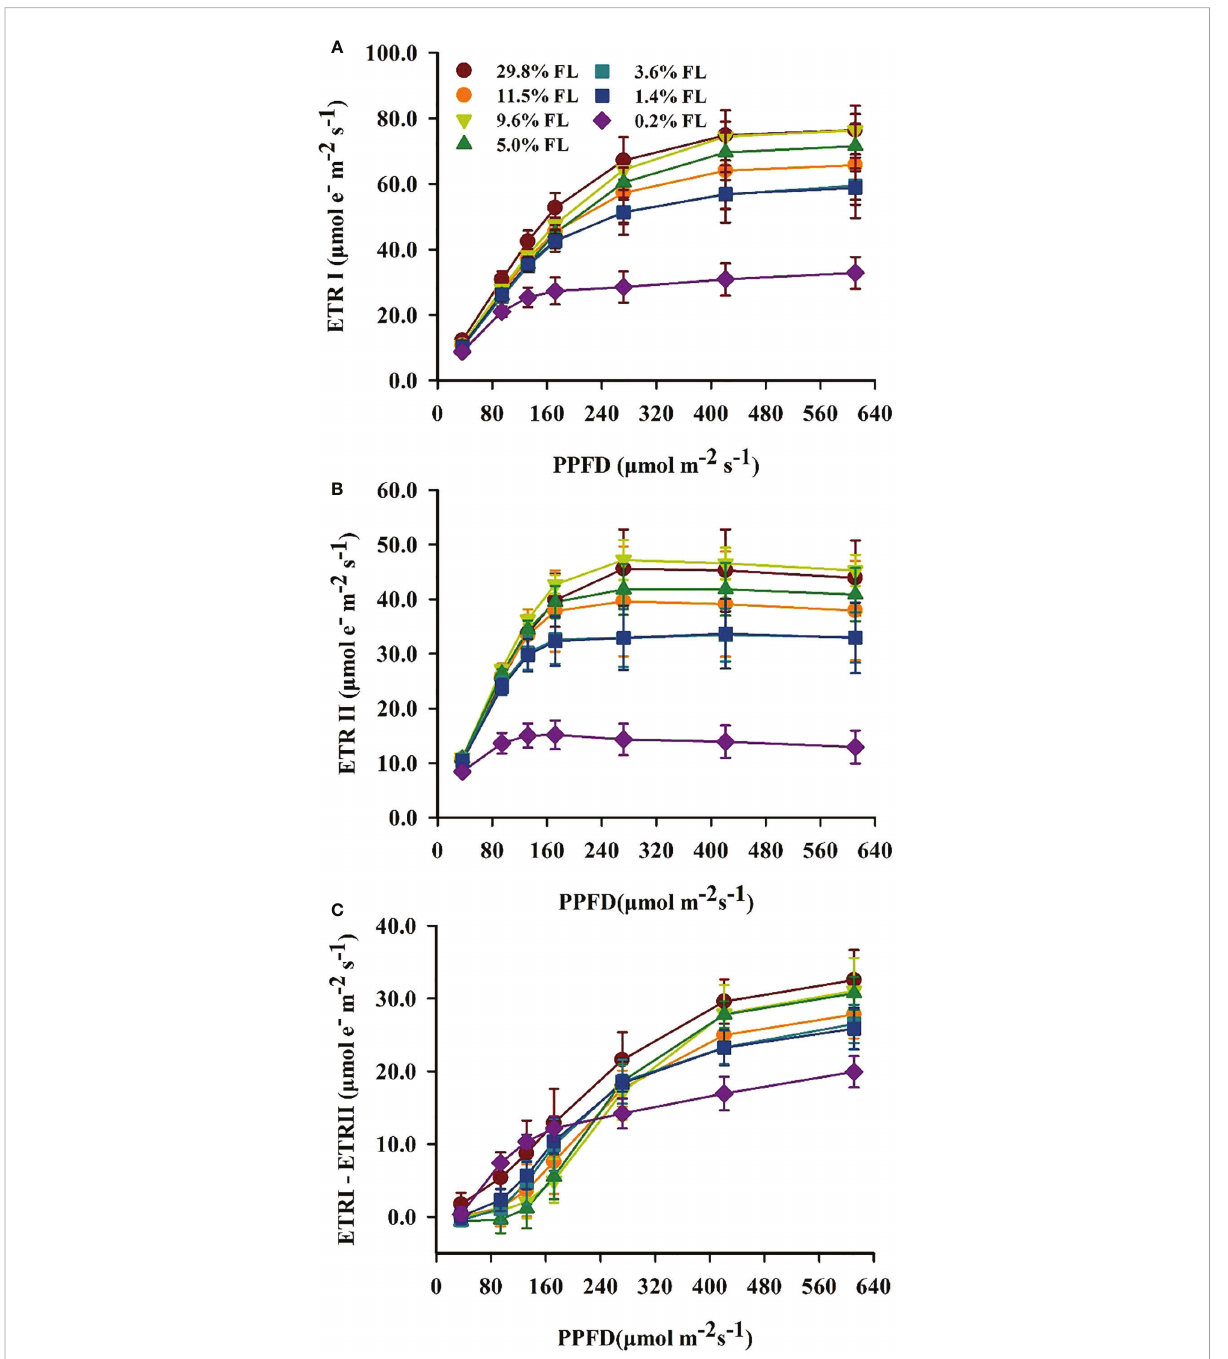
FIGURE 4 Characteristics of electron transport between PSII and PSI in 1eaves of P. notoginseng grown under different light levels. (A) Response of electron transport rate of PSI (ETRI, m mol·e - ·m -2 ·s -1 ) to photosynthetic photon fl ux density (PPFD, m mol·m -2 ·s -1 ). (B) Response of electro transport rate of PSII (ETRII, m mol·e - ·m -2 ·s -1 ) to PPFD. (C) Response of cyclic electron fl ow around PSI (ETRI - ETRII, m mol·e - ·m -2 ·s -1 ) to PPFD. Values for each point were means ± SD ( n =